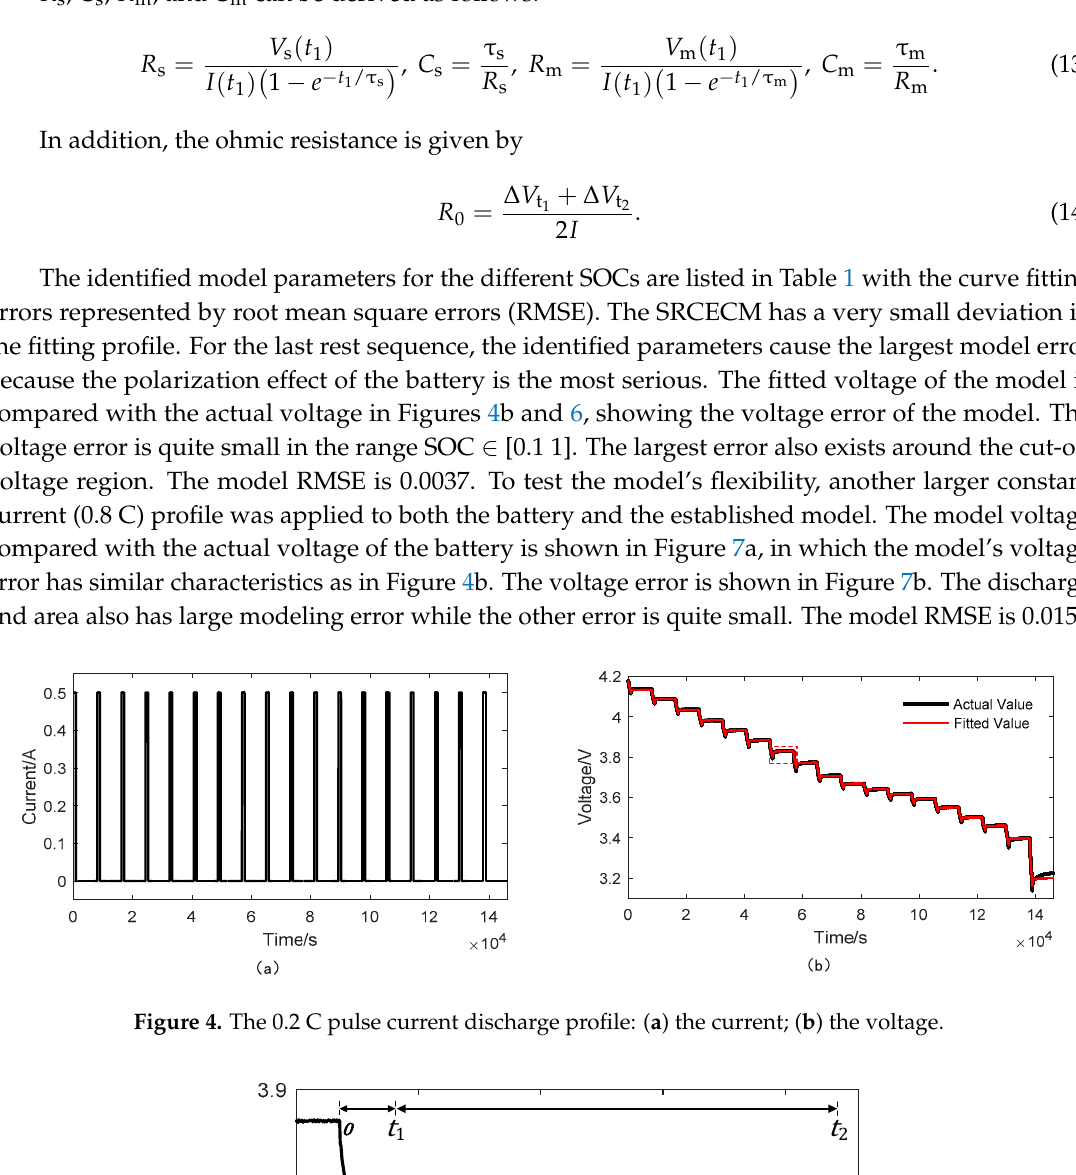
Figure 5. Transient voltage response.